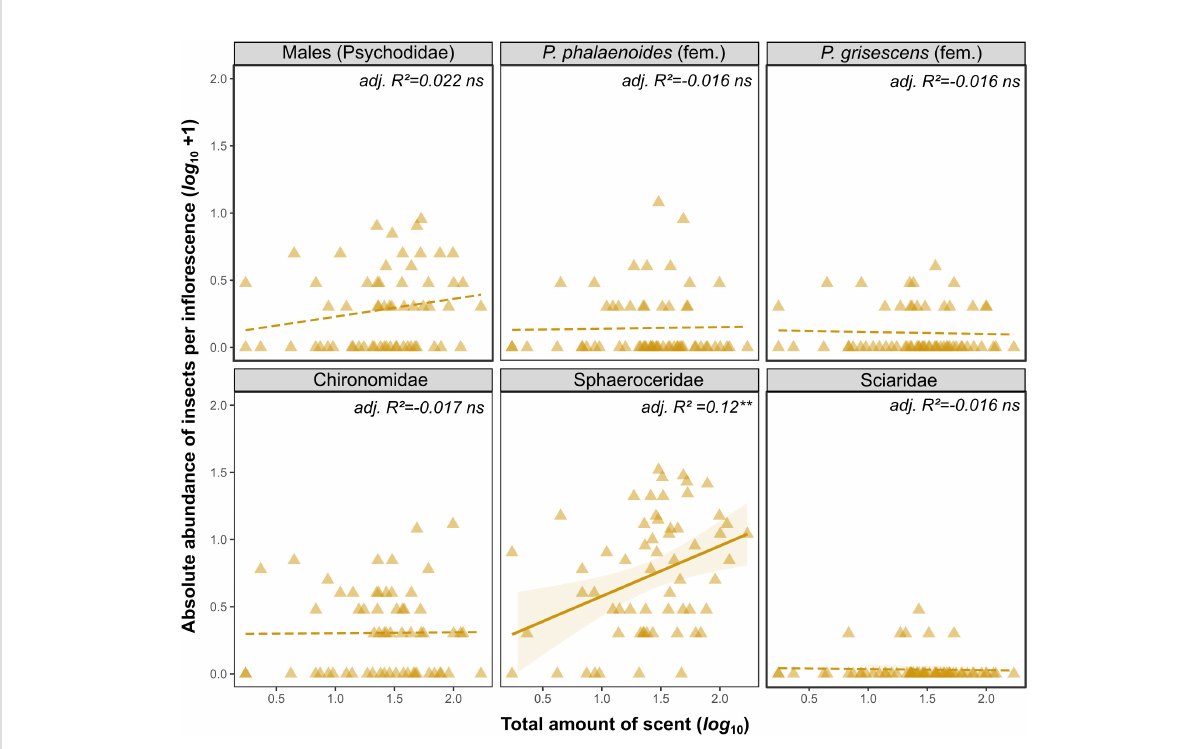
FIGURE 4 Linear regressions between the absolute abundance of individual insect groups ( log 10 +1) and total amount of scent emitted ( log 10 , ng in fl orescence -1 5 min -1 ) per Arum maculatum individual for the DAO population (see Figures 3 and text for details). Solid and dashed lines indicate signi fi cant (** 0.001 < P ≤ 0.01) and non-signi fi cant ( ns , P > 0.05) model fi tting, respectively. Shaded areas indicate 95% con fi dence intervals around regression lines. P. , Psychoda ; fem,